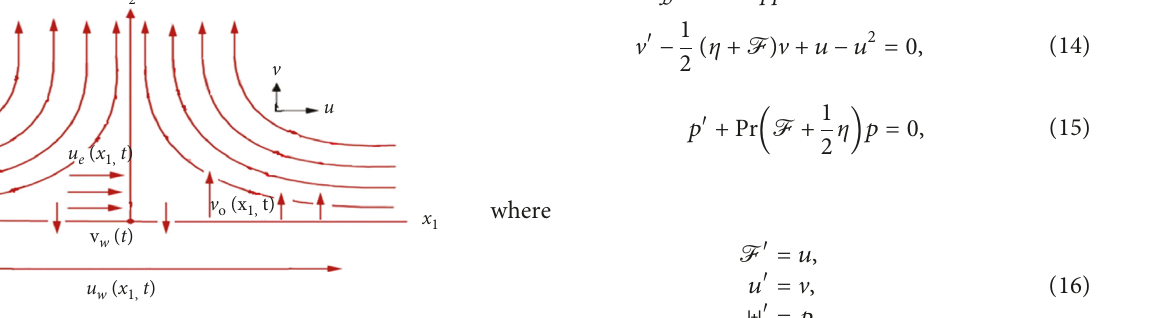
Figure 1: Schematic